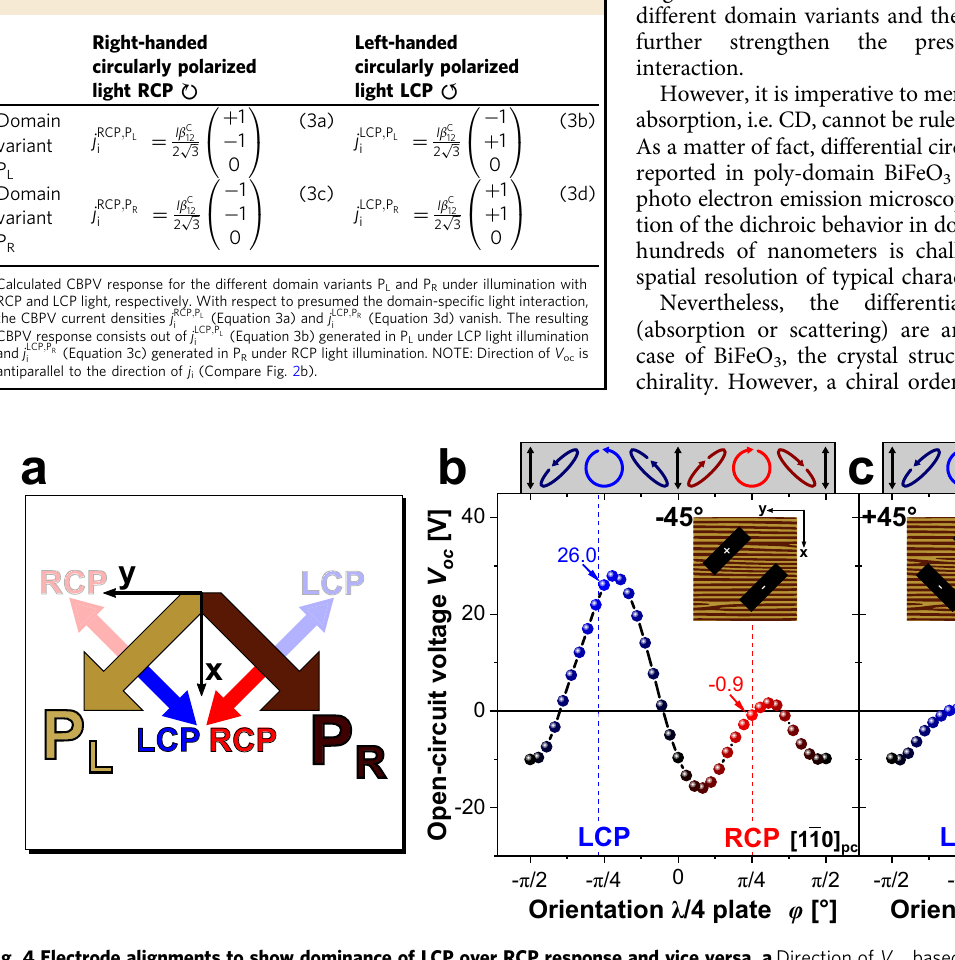
( − 45 ∘ ). and c [110] pc ( + 45 ∘ ). pc